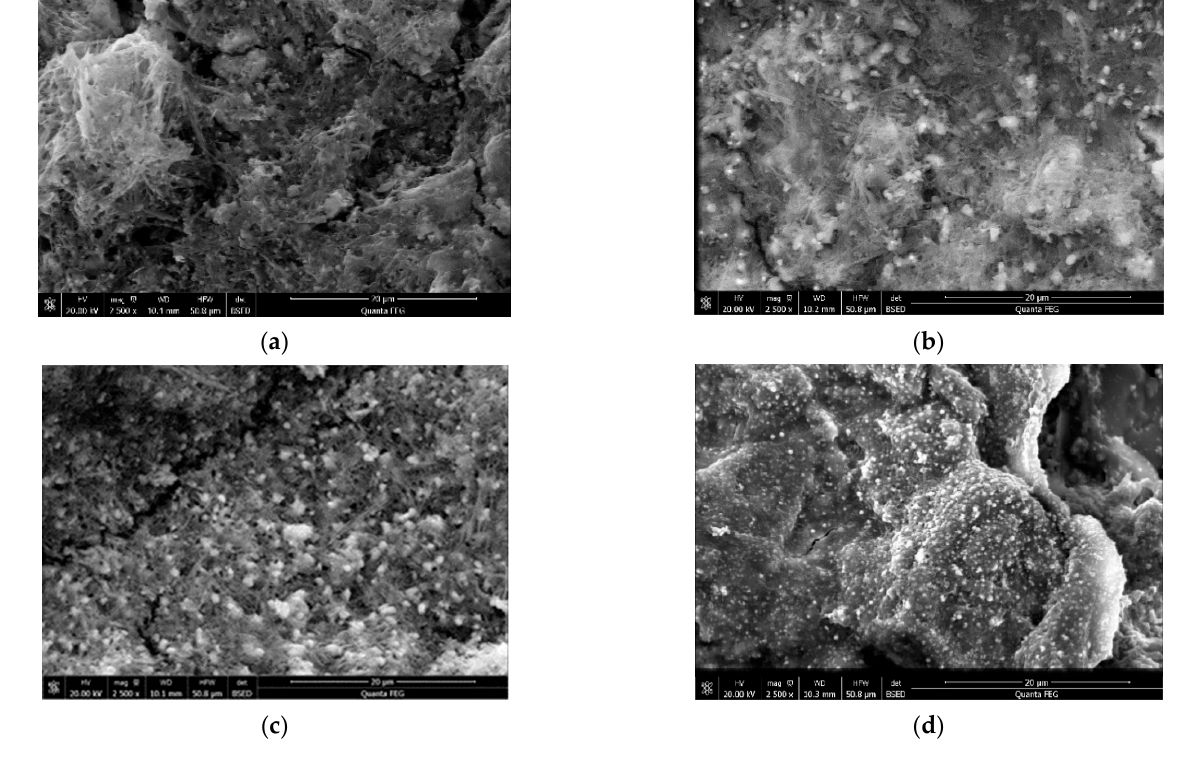
Figure 5. BSEM images of different Ag/AgCl surface depositions: ( a ) VPFWC-1.70; ( b ) VPFWC-8.31; ( c ) VPFWC-16.62; ( d ) VPFWC-32.35.